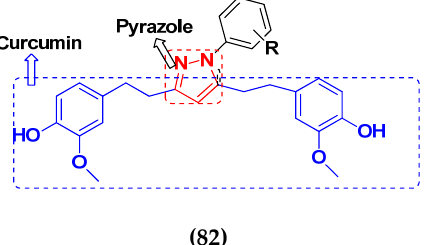
Figure 79. Structure of curcumin-pyrazole derivative ( 82 ). Table 68. In vitro cytotoxic activities of curcumin ‐ pyrazole hybrid compounds 82 ( a – c ).